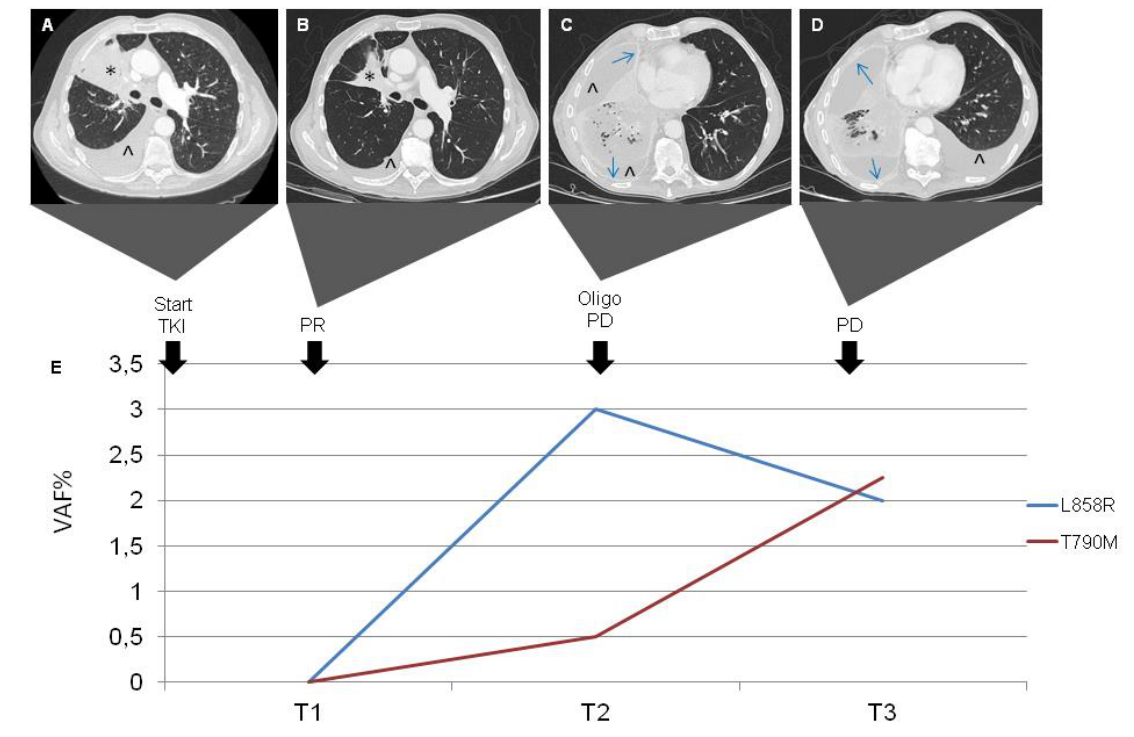
Figure 4. History of disease of the patient described as Case 1. Radiologic responses to TKI treatment paired with circulating activating and resistance EGFR mutation. CT shows reduction in size both of lung cancer (*) and pleural effusion (ˆ) localized in the right lung from baseline ( A ) to the fist control ( B ). Relapse with complete filling of right pulmonary air spaces, malignant pleural thickness (blu arrow) and pleural effusion ( C , D ). Longitudinal VAF of L858R and T790M mutations in cfDNA ( E ).